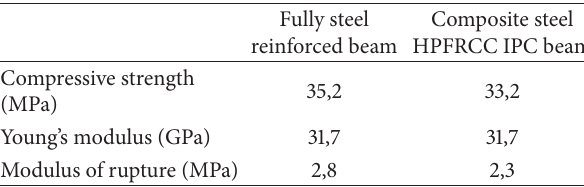
Table 2: Material characteristics of concrete.